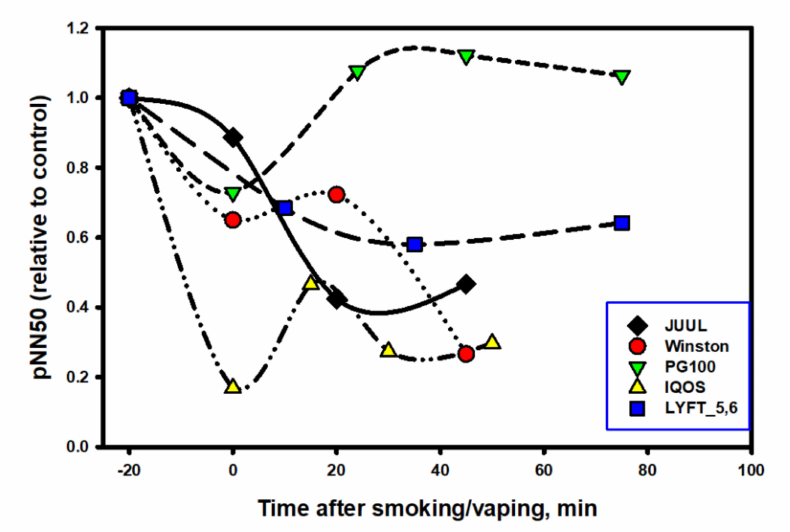
Figure 7. HRV dynamics (percentage of adjacent RR intervals differing by more than 50 ms) after the use of different nicotine-containing products by a smoking volunteer. Electronic cigarette with a nicotine-free filler (100% propylene glycol) was used as a control. The subject took 8 puffs in 3.5 min for all smoking simulators, including cigarettes, and also used a nicotine pack for 40